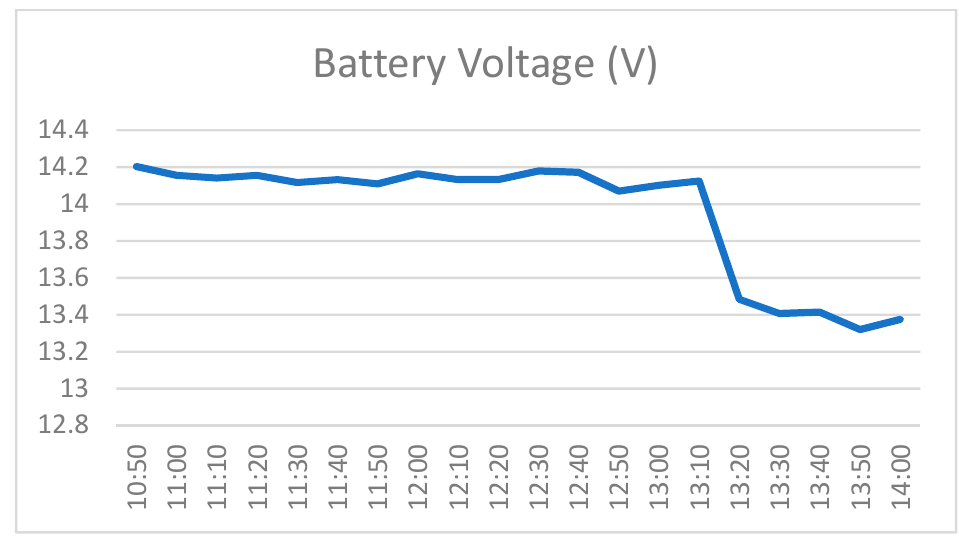
Figure 9. Battery Voltage Decreasing After Fully Charged.